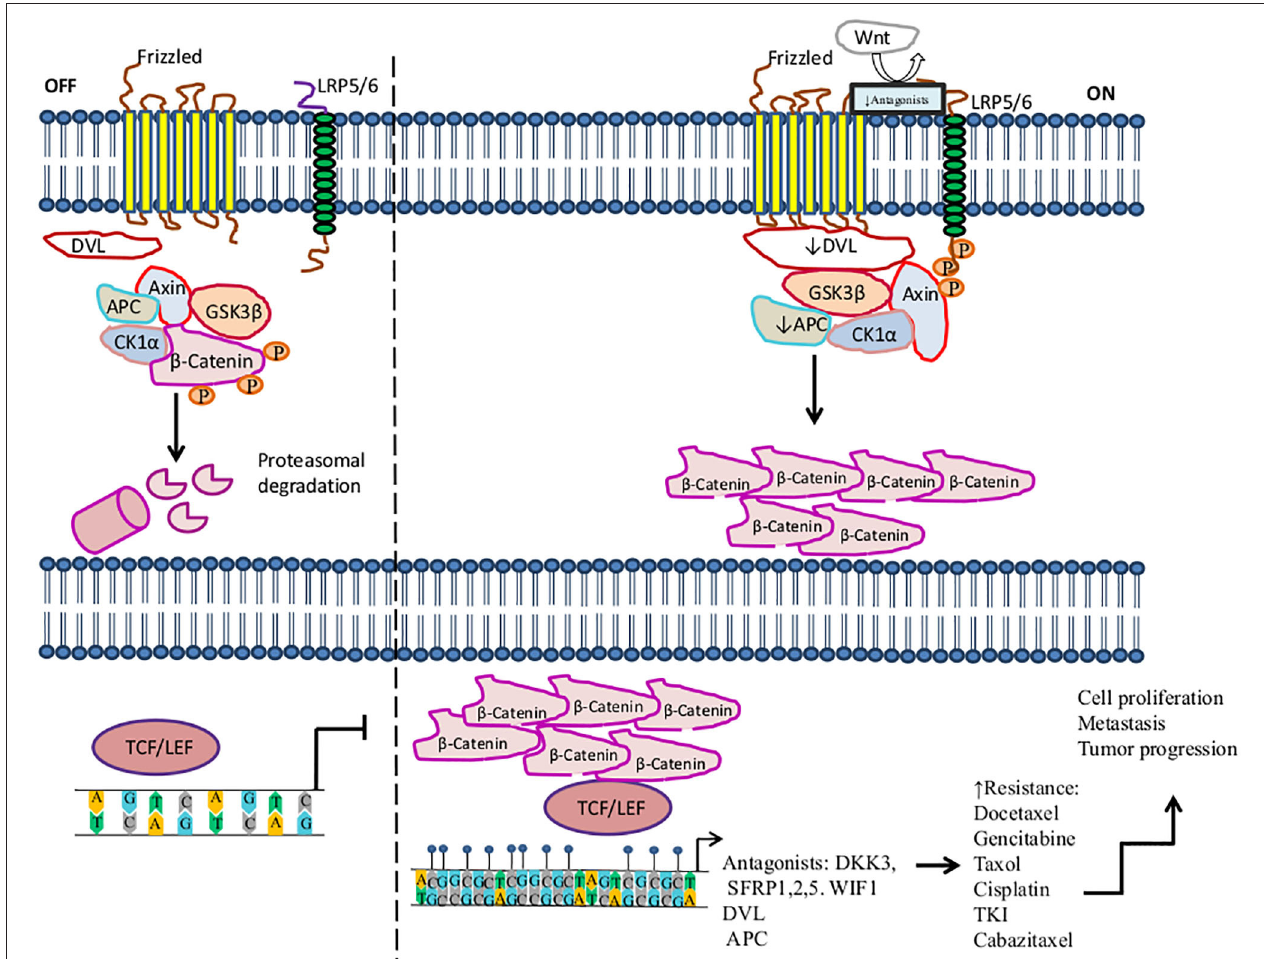
FIGURE 1 | Activation of the Wnt/ β -catenin signaling pathway in the resistance to therapy in cancer by methylation. The canonical Wnt/ß-catenin pathway is activated by the binding of Wnt to the Frizzled receptor (Fzd). Then LRP is phosphorylated by casein kinase 1 (CK1 α ) and glycogen synthase kinase 3 beta (GSK3 β ) associated with tumor suppressor adenomatous polyposis coli (APC). LRP phosphorylation promotes the recruitment of disheveled proteins (DVL) to the plasma membrane, where they are polymerized and activated. DVL complex interacts with Axin, which inhibits the degradation of β -catenin and leads to its accumulation in the cytoplasm and translocation into the nucleus, where β -catenin promotes the activation of LEF/TCF transcription factors inducing the transcription of several genes. In the absence of Wnt, β -catenin is a target of the destruction complex conformed by Axin, CK1 α , APC, and GSK-3 β . CK1 α and GSK-3 β phosphorylate β -catenin, promoting its ubiquitination by the β -TrCP ubiquitin ligase and degradation through the proteasome. On the other hand, this figure shows some aberrantly methylated key genes that increase resistance to therapeutic agents and the dysregulation of the Wnt/ β -catenin signaling pathway. These genes play an antagonist role in the Wnt pathway, for instance, Dickkopf-related protein (DKK3), secreted frizzled-related proteins (SFRP1, SFRP2), and WNT inhibitory factor-1 (WIF1), which are tumor suppressor genes and inhibit the signaling of Wnt to bind LRP5/6 receptors. , phosphorylation; ↑ , increase; ↓ , decrease, ,